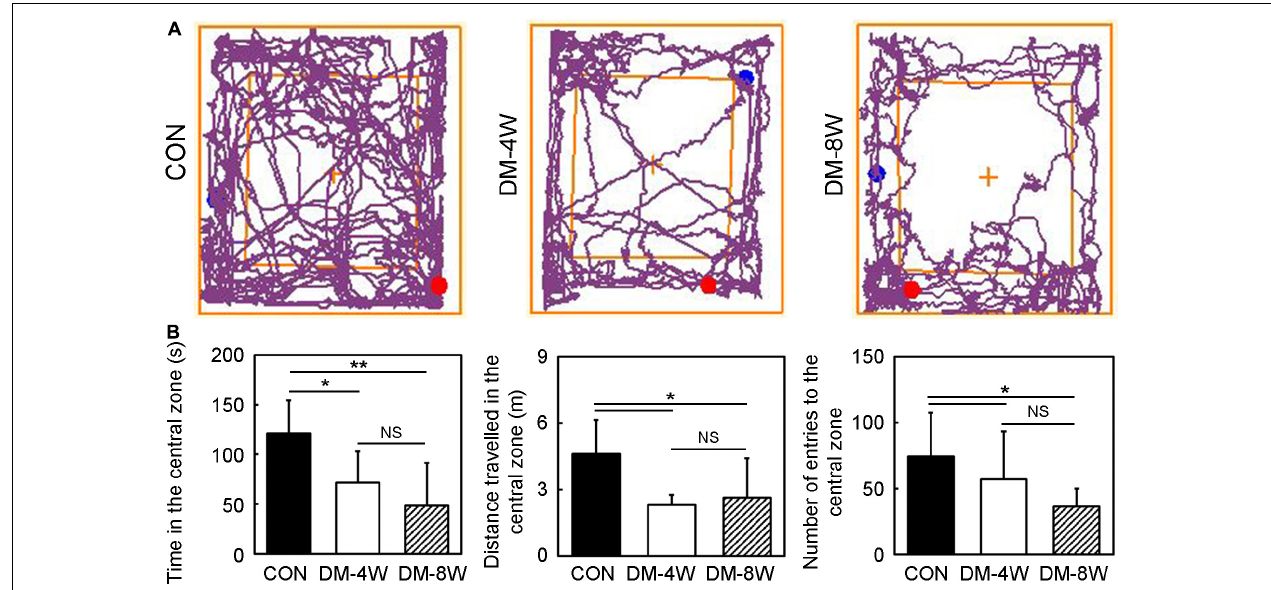
FIGURE 3 | Anxiety and exploratory behavior increased in diabetic mice. (A) The track plot showed the mouse trace of the control, DM-4W and DM-8W groups in the open field test. (B) Bar graphs showed the time in the central zone, the distance traveled in the central zone and number of entries to the central zone. Data are mean ± SD , n = 8 per group, * p < 0.05, DM-4W or DM-8W vs. control;** p < 0.01, DM-8W vs. control.